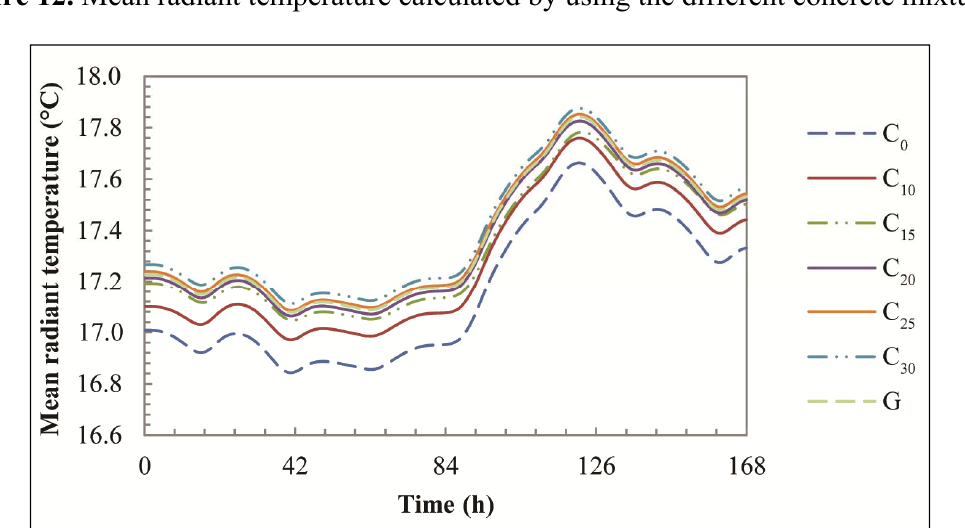
Figure 12. Mean radiant temperature calculated by using the different concrete